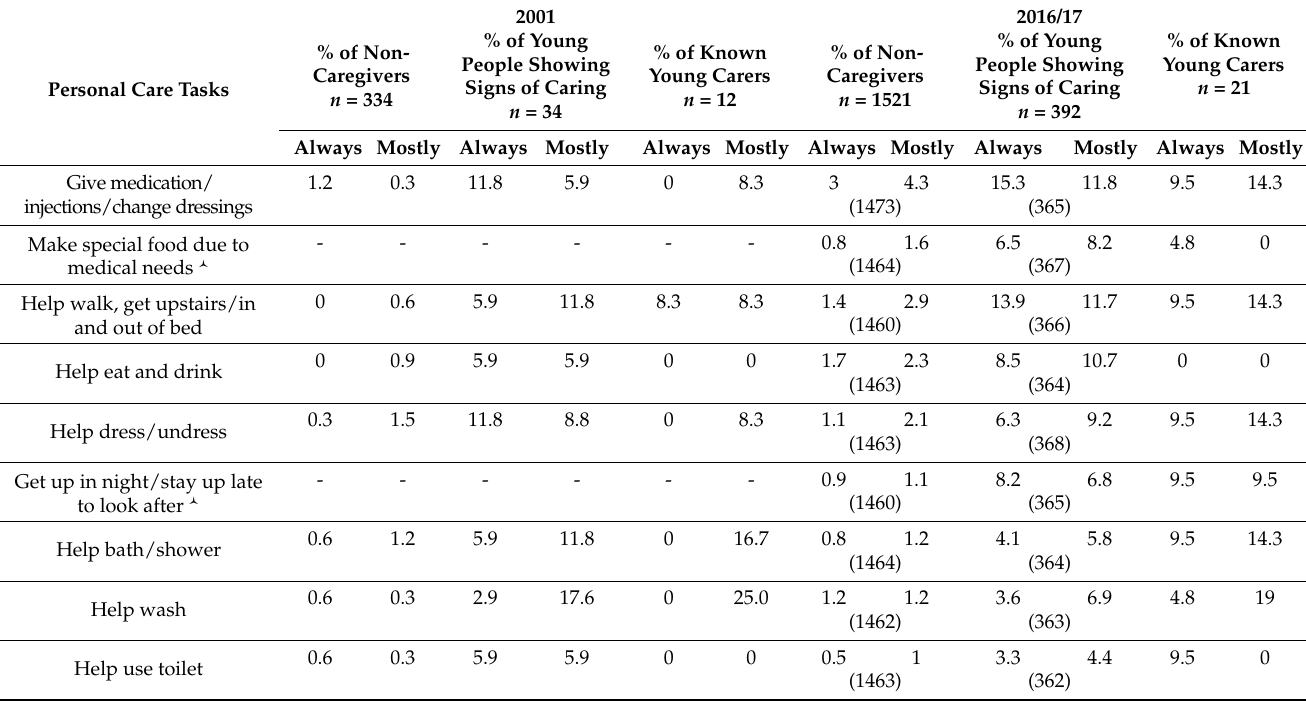
Table 3. Nature of general and other care tasks undertaken by non-caregivers, young people show- ing signs of caring and known young carers in 2001 and 2016/17. Table 6. Frequency of personal care tasks undertaken by non-caregivers, young people showing signs of caring and known young carers in 2001 and 2016/17.